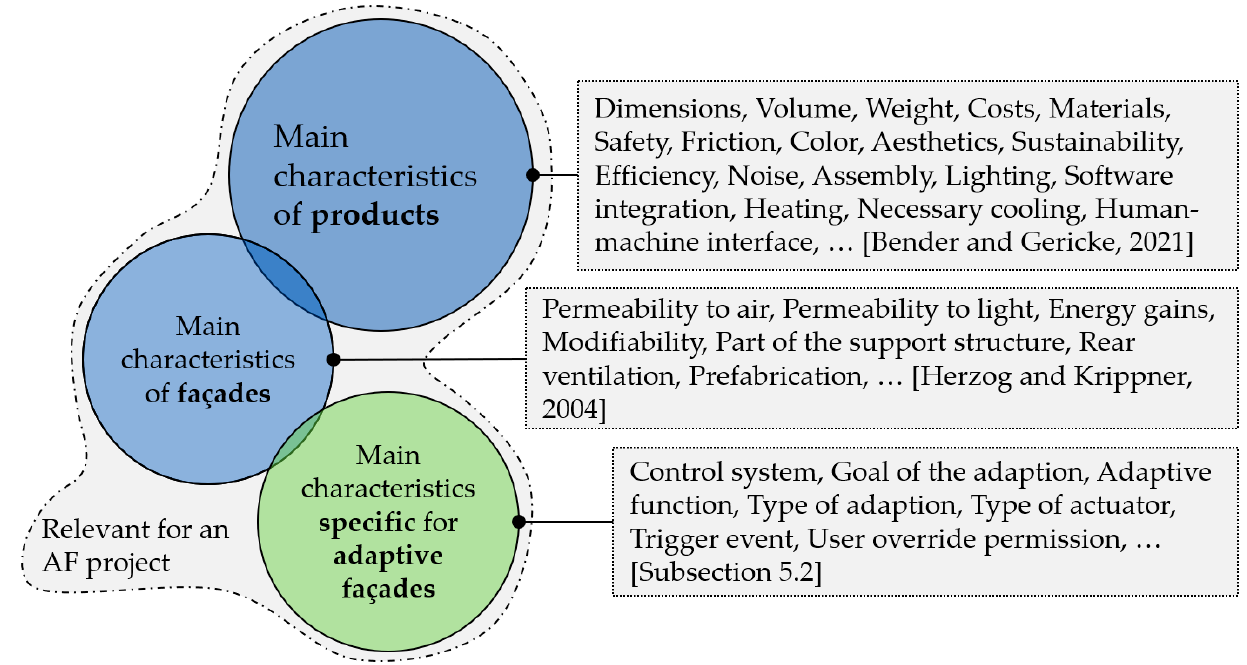
Figure 12. Schematic visualization of the relationships between the different sets of characteristics [1,30].